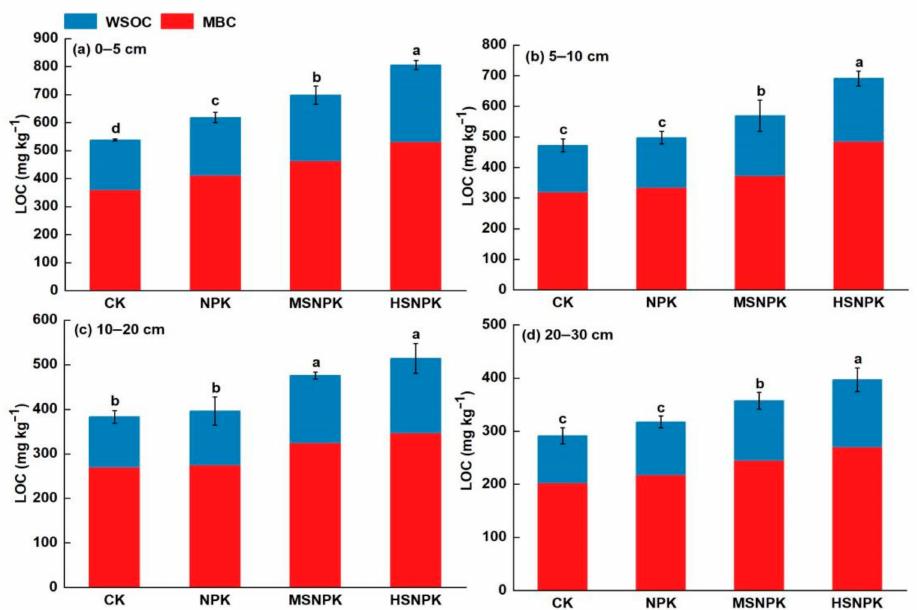
Figure 6. Changes in soil LOC content at different soil layers under different treatments. The values are means ± SD ( n = 3). Different letters mean statistically significant differences at the 0.05 level. CK: unfertilized control; NPK: mineral NPK fertilizer; MSNPK: moderate wheat straw incorporation (3 t ha − 1 ) plus NPK; HSNPK: high wheat straw incorporation (6 t ha − 1 ) plus NPK. LOC: labile organic C; WSOC: water-soluble organic C; MBC: microbial biomass C.